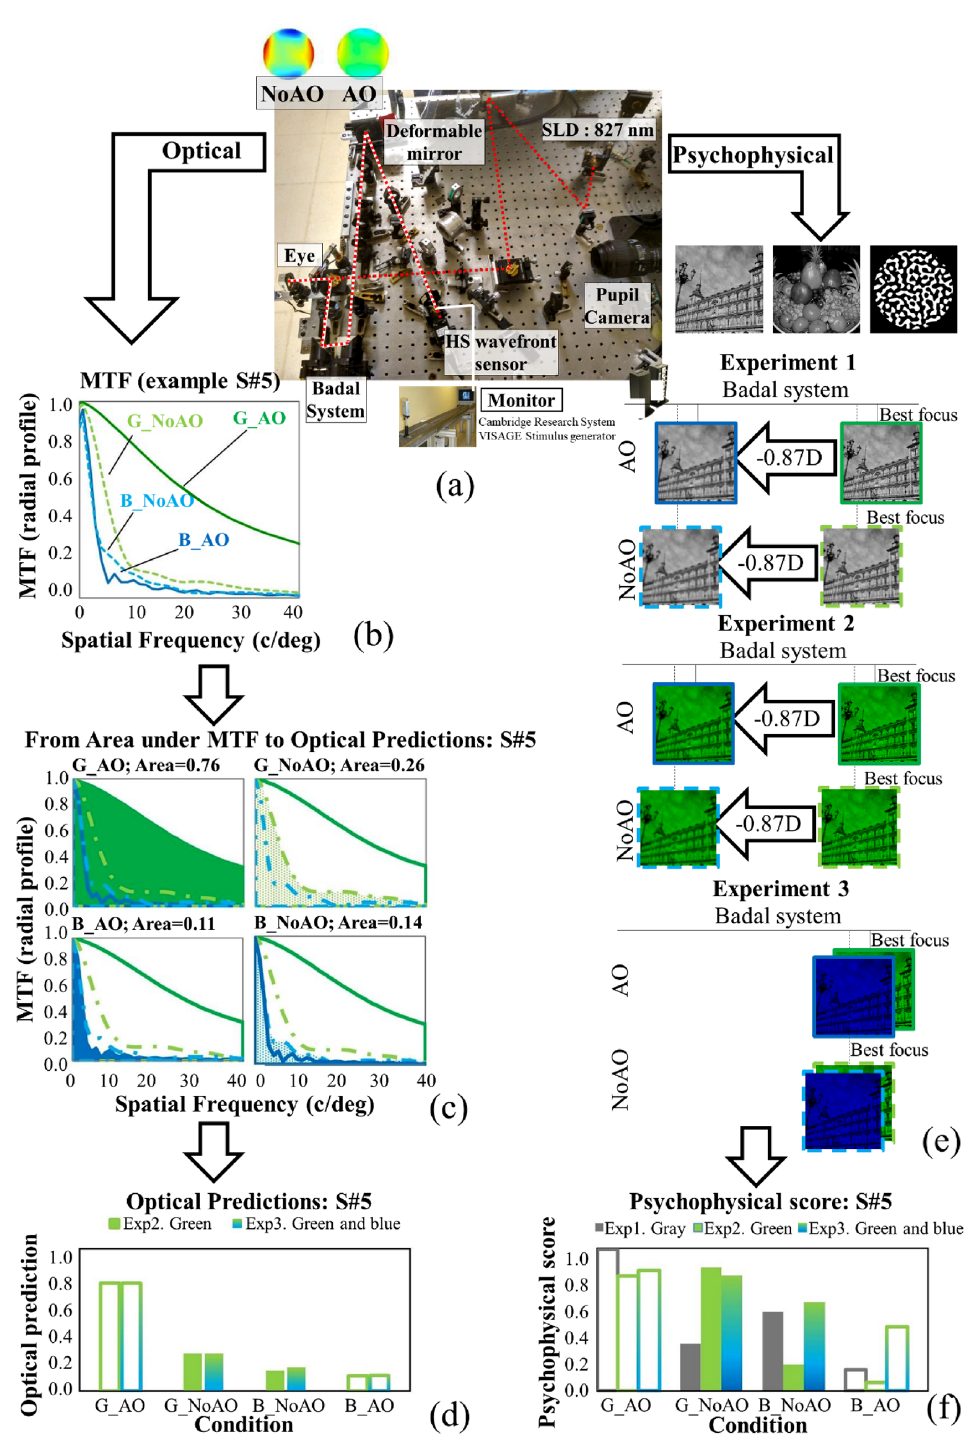
Figure 1. Methods overview. Example of Optical predictions (left) and Psychophysical scores (right) for one subject (S#5) from experimental measurements in the Adaptive Optics system (with natural and AO-corrected aberrations, depicted in ( a )). The optical modulation transfer functions (MTFs) were obtained from the measured wave aberrations at best focus for Green (NoAO, dotted line and AO, solid line) and for a defocus corresponding to the chromatic difference of focus for Blue ( b ). Optical quality predictions are estimated computing the normalized area under the MTF (0–40 c/deg range) ( c , d ). The patients then scores the perceived quality of natural images (city scene, fruit platter and binary noise) of gray-scale images (in focus, and defocus by − 0.87 D), green images (in focus, and defocus by − 0.87 D), and green and blue images (in the best focus of green), both with natural aberrations (NoAO) and aberration correction (AO), illustrated in ( e ). Psychophysical scores are obtained from the perceptual judgment of natural images (0–5) as seen through the Adaptive Optics system in 4 conditions (G_AO, G_NoAO, B_NoAO) and normalized to 1 ( f ). Note that G_AO and G_NoAO means best focus of gray-scale images in Exp 1 and best focus for green in Experiment 2 and 3, for AO and NoAO conditions, respectively, and B_AO and B_NoAO means − 0.87 D from the best focus of gray-scale images and green images, for Experiment 1 and 2, respectively, and best focus of green (with blue stimuli) in Experiment